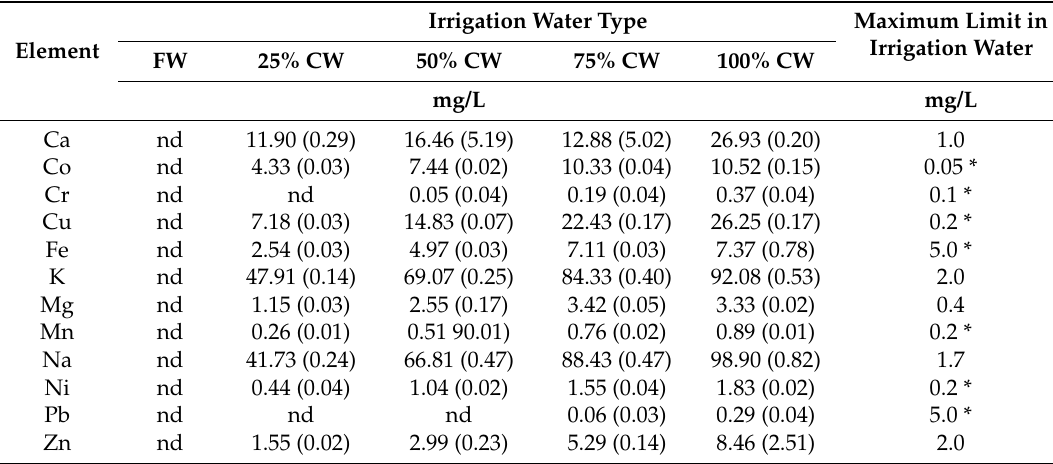
Table 2. Mean concentration (mg/L) of elements determined in fresh and contaminated water. Numbers in parentheses are the standard errors of the means of three